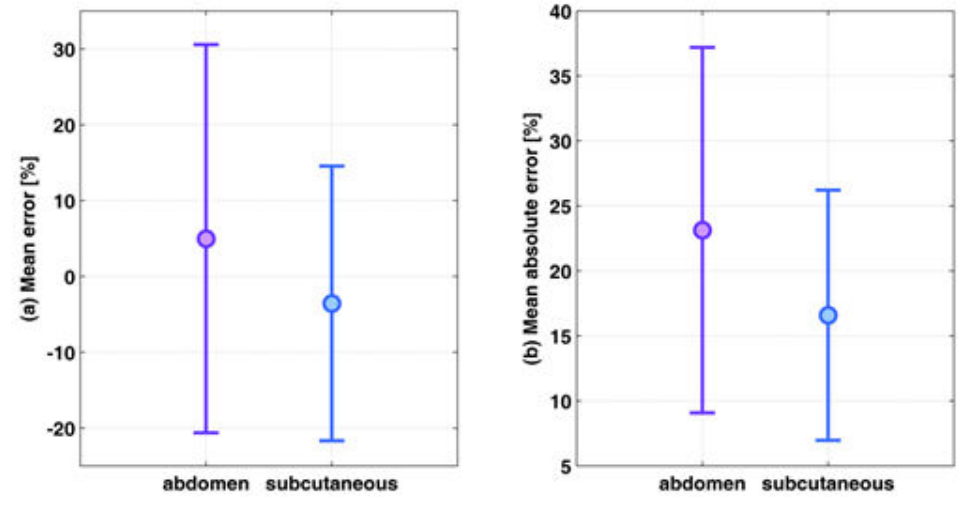
Figure 2. ( a ) The mean error of estimated concentration ratio (circle symbols) with their 90% confidence interval, for the abdomen tubes (purple) and subcutaneous (blue); ( b ) the mean of absolute errors of estimated concentration ratios (circle symbols) with their 90% confidence interval, for the abdomen tubes (purple) and subcutaneous